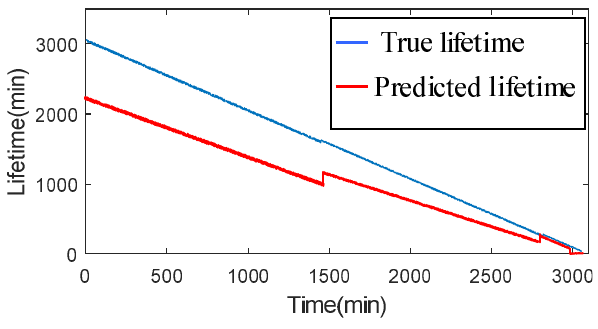
Fig. 7 The lifetime curve of prediction